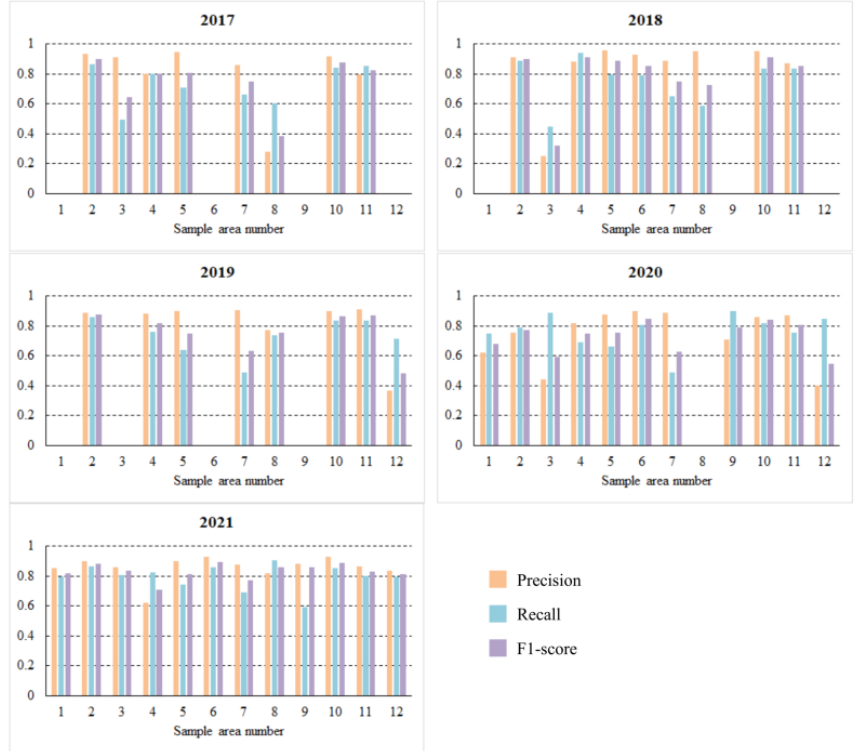
Figure 11. Accuracy evaluation chart for each sample area for each year from 2017 to 2021. Sample areas numbered 1, 6, and 9 in 2017, sample areas numbered 1 and 9 in 2018, sample areas numbered 1, 3, 6, and 9 in 2019, and sample area numbered 8 in 2020 are not involved in the accuracy evaluation due to the presence of a large number of clouds.